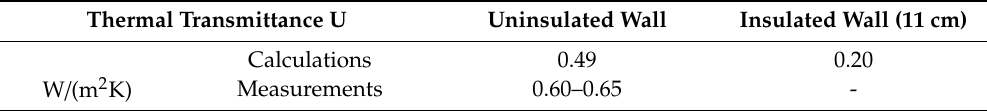
Table 6. Comparison of results (for the alternative featuring thermal insulation with mineral wool λ = 0.038 W / (mK)).